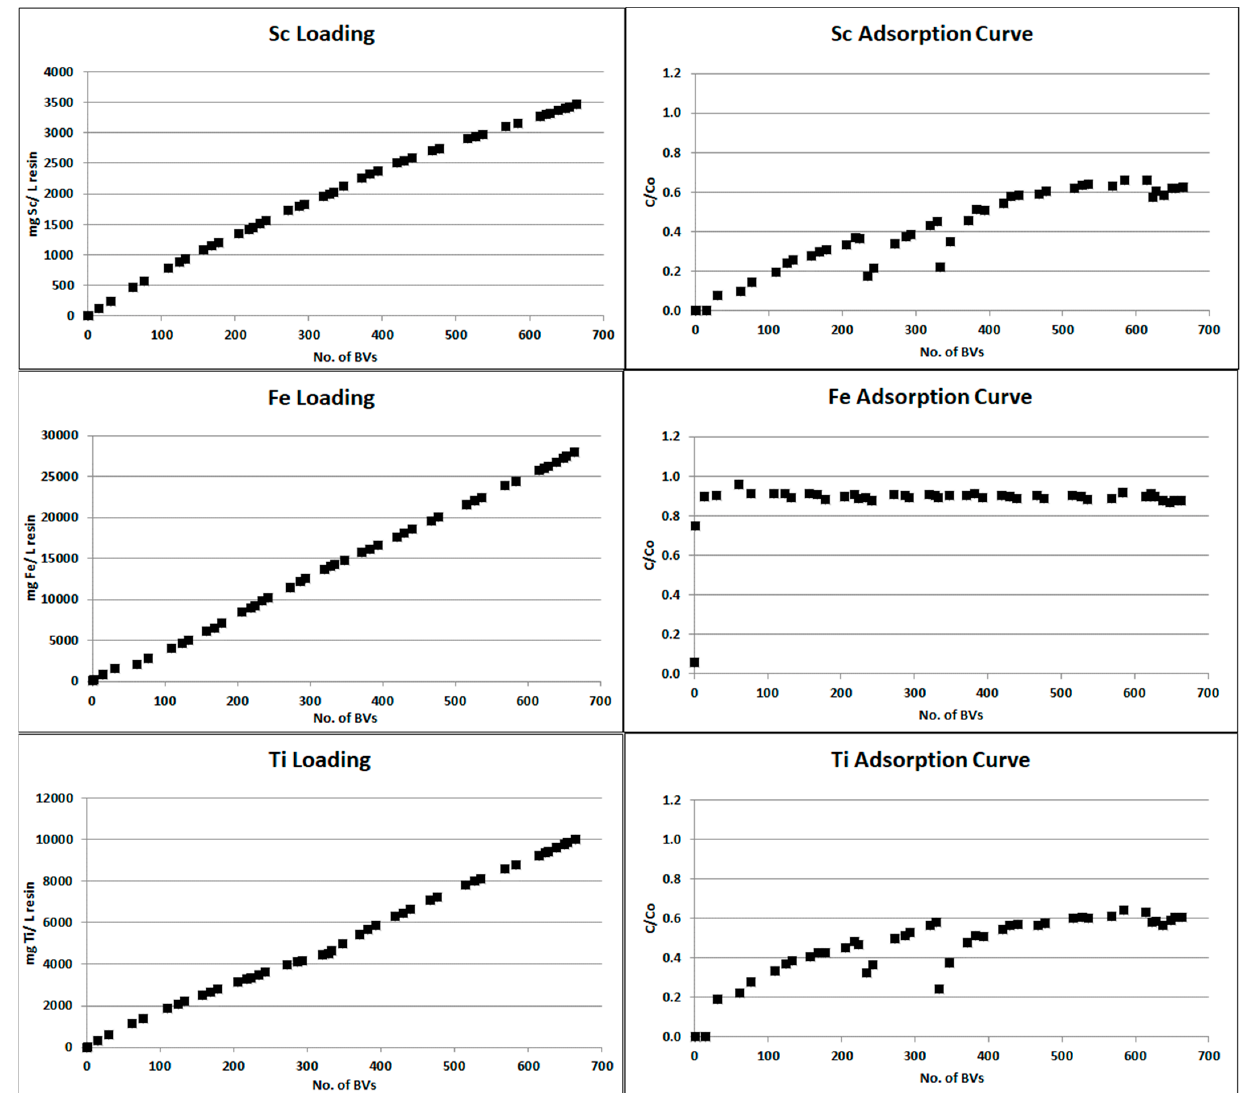
Figure 4. Loading (mg of cation/L of resin) and adsorption (concentration of solution exiting the column to initial PLS concentration) curves for Sc, Fe and Ti against number of Bed Volumes (BVs) passed through the resin column.